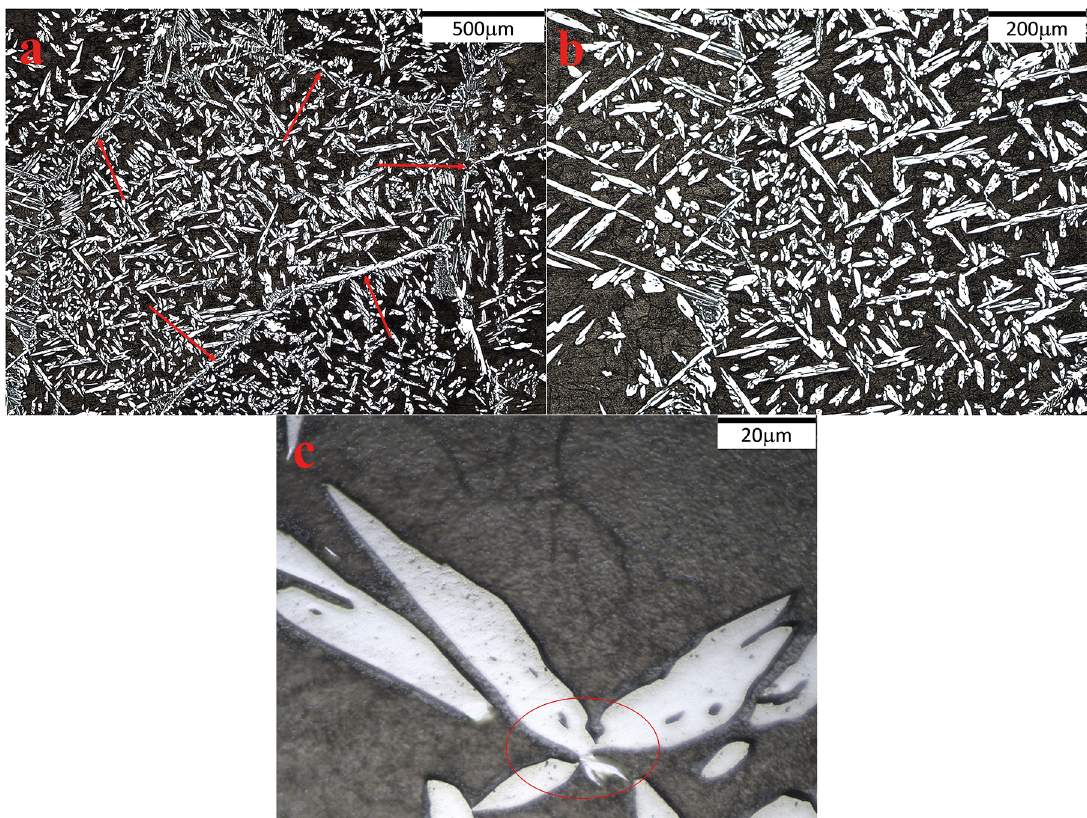
Figure 6. Micrographs of D4 condition (a) allotriomorphic austenite - OM-50x; (b) different coexisting morphologies of austenite OM- 100x; (c) intragranular austenite sympathetically nucleated OM-1000x. Behara II.